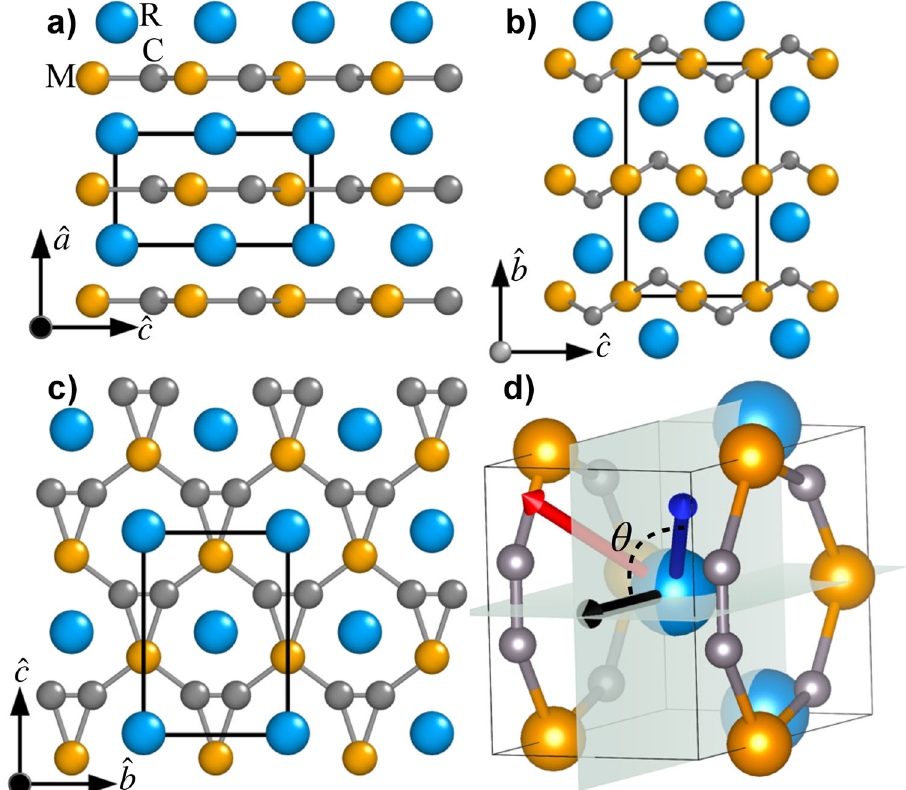
Fig. 1 Crystal structures of RMC 2 . a , c , d Compounds with noncentrosymmetric Amm 2 space group, and b Cmcm space group. a , b illustrate the layered structure, formed by a quasi-planar network spanned by the transition metal carbide complex, MC 2 , while the rare-earth ions, R, occupy the interstitial space between the layers. In d , re fl ection symmetry planes are depicted in green while the arrows indicate directions [001] (black), [111] (red) and [ − 111] (blue). The conventional unit cells are indicated by black solid